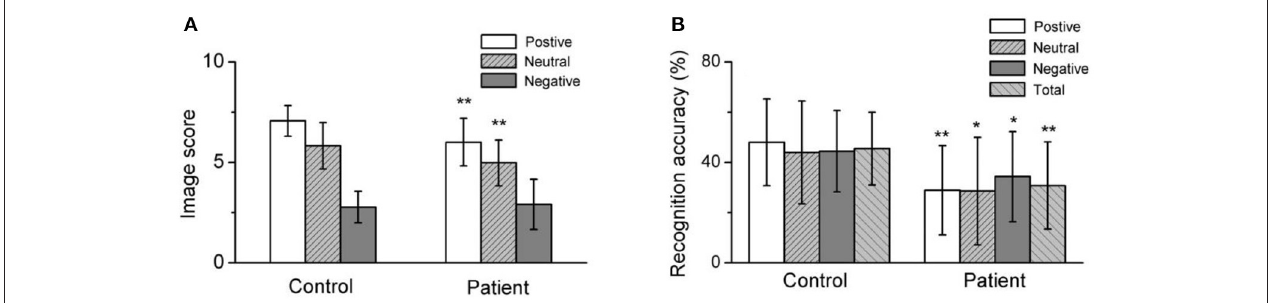
FIGURE 1 | Both the positive image score and recognition accuracy, neutral image score and recognition accuracy, negative image recognition accuracy, and total recognition accuracy in depressed patients were significantly lower than healthy control. (A) Summarized data for the image score of different emotional image. (B) Averaged data for the recognition accuracy of different emotional image. * p < 0.05, ** p <